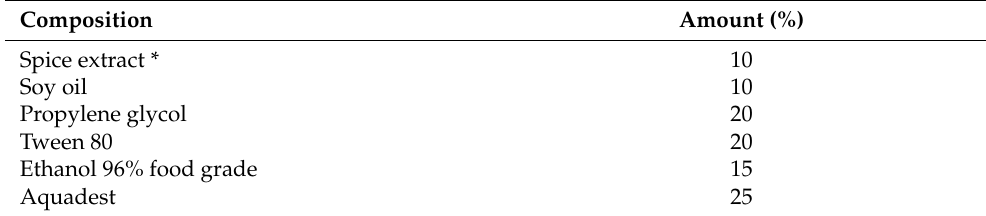
Table 4. Macroemulsion